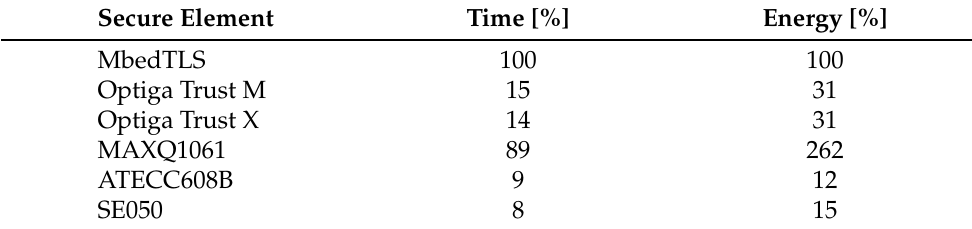
Figure 11. Time and energy measured for verifying an ECDSA signature (secp256r1) relative to the reference implementation. (median of values, rounded to the nearest percent, n = 100). Table 5. Table of values for Figure